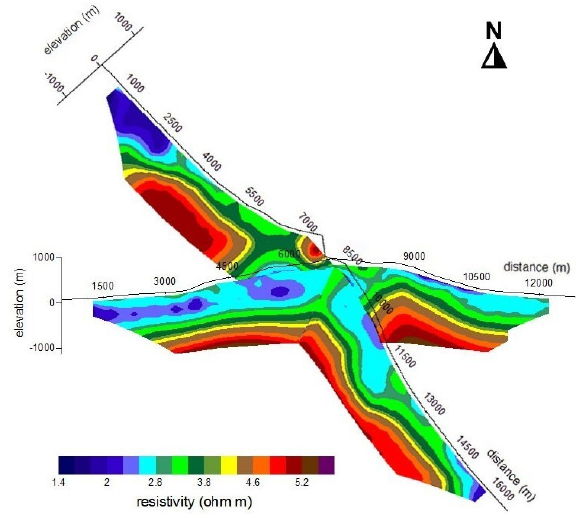
Figure 11. Intersection of the 2D resistivity tomographies carried out along the approximately N-S and W-E profiles of Figure